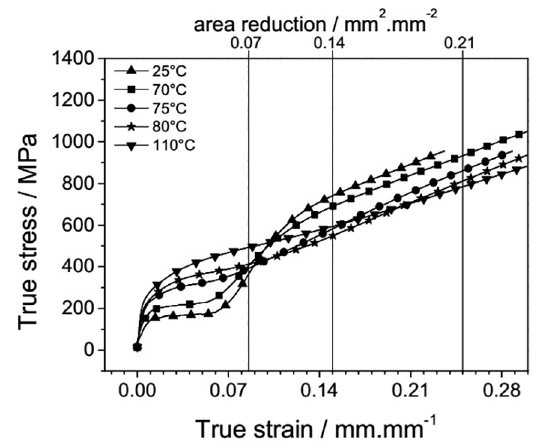
Figure 3. True stress-strain curves of solution treated 2.080 mm wire tensile tested at 25, 70, 75, 80, and 110 (60.6 S